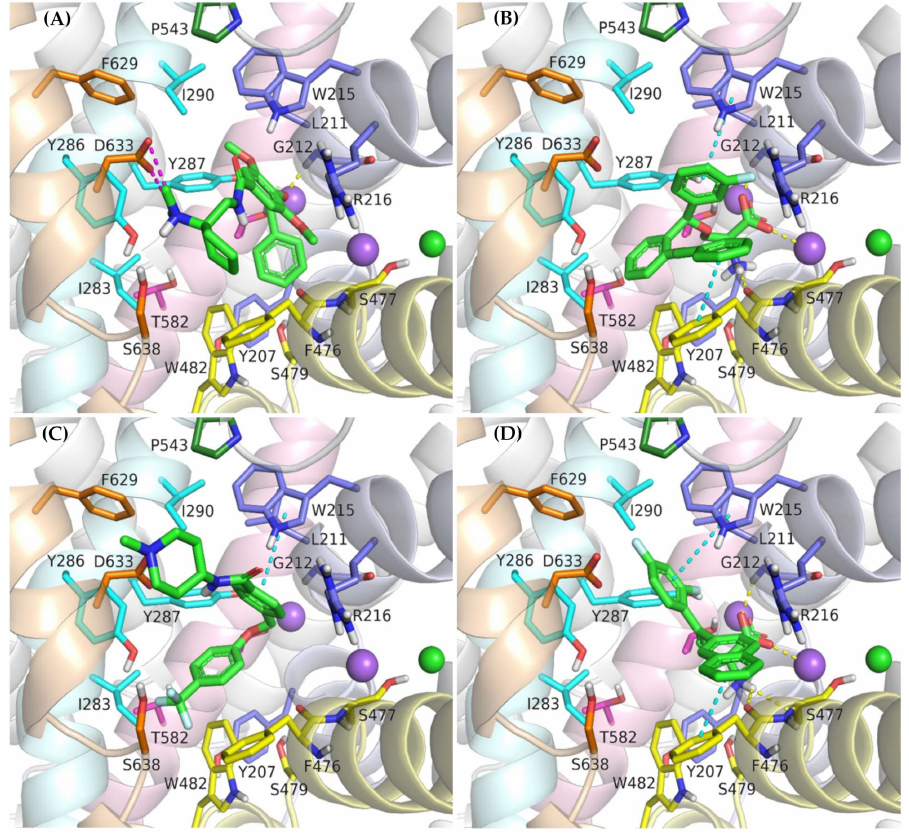
Figure 9. Binding mode of the inhibitors within GlyT-2 in an outward-open state: ORG-25543 ( A ); ALX-1393 ( B ); GT-0198 ( C ); compound 9 ( D